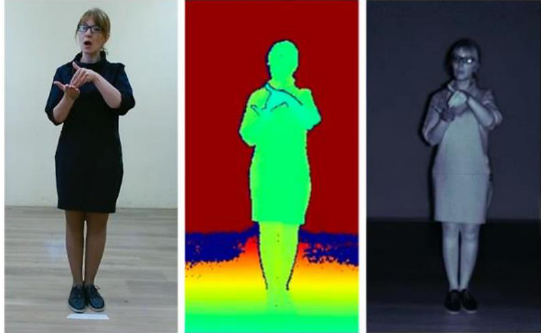
Figure 2 . Examples of video frames showing RSL gestures in FullHD format, in depth map mode, and in the infrared range from the TheRuSLan multimodal corpus.